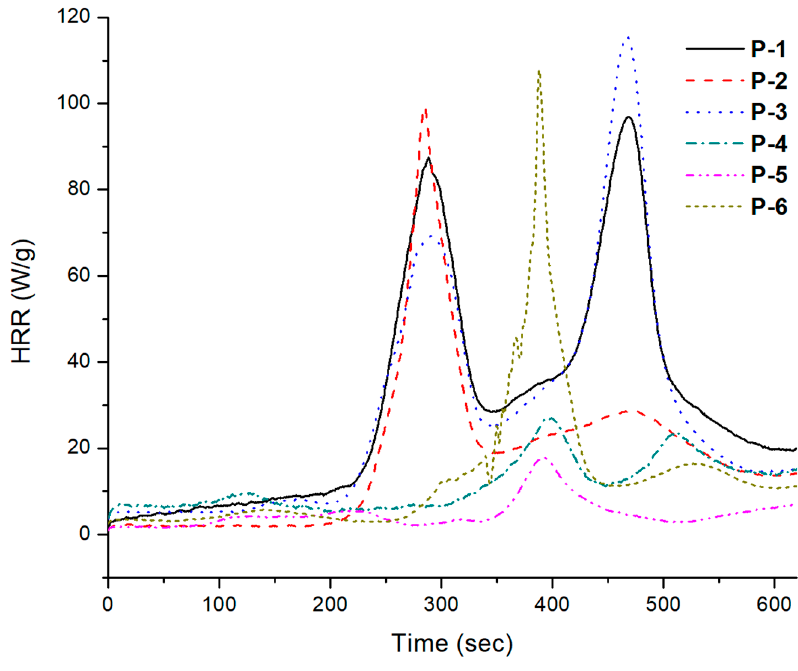
Figure 13. Photographs taken during direct flaming/combustion of a reference polymer ( RP ; top row) and ionic polymers ( P-1 , P-2 , and P-3 ) (bottom three rows).